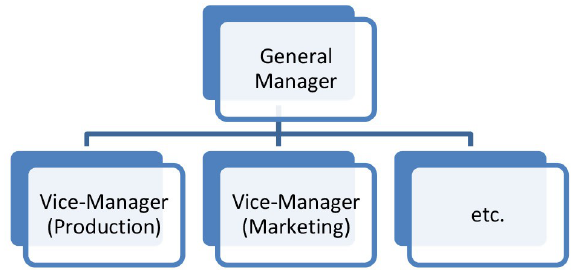
Figure 4. Department based organizational scheme